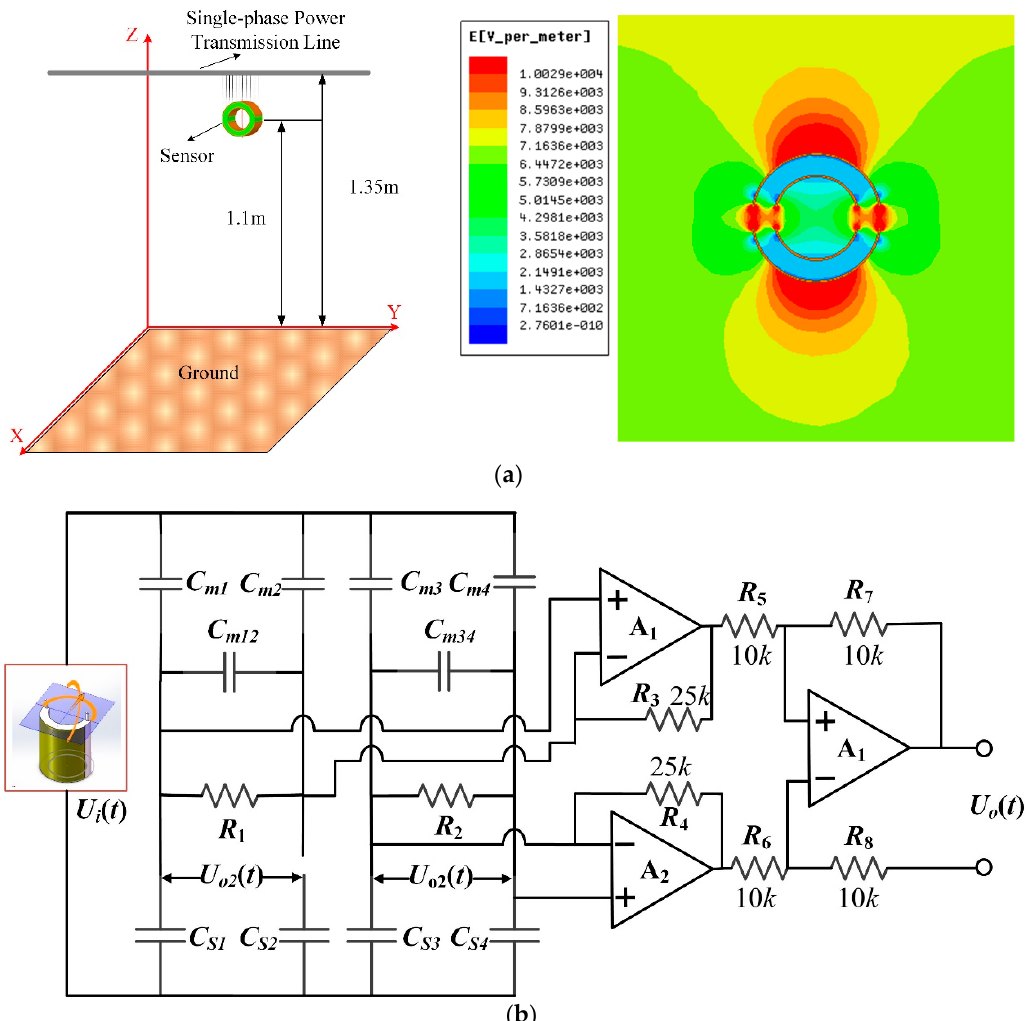
Figure 6. Physical model of Field-Circuit coupling and circuit connection diagram: ( a ) Sensor simulation model and electric field distribution; ( b ) Equivalent circuit connection diagram.